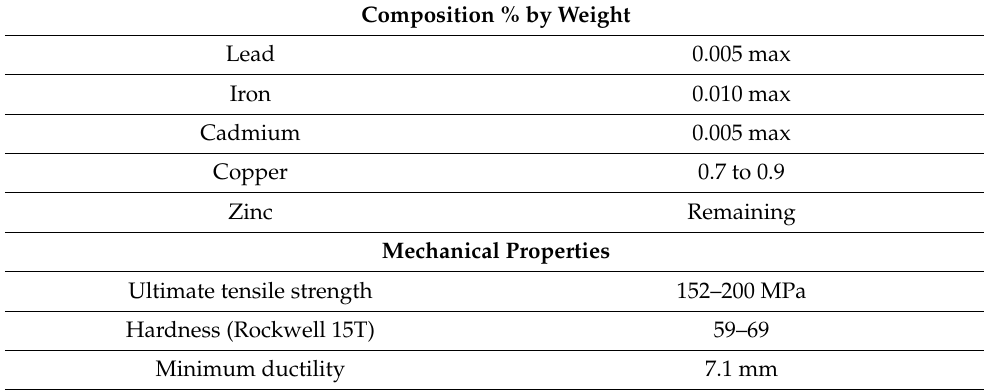
Figure 8. Specimen production with rebar and Zn mesh anode for CP performance evaluation. ( a ) Rebar; ( b ) Zn mesh anode; ( c ) Specimen preparation; ( d ) Manufactured specimen. Table 4. Composition and mechanical properties of Zn mesh anode. Table 4. Composition and mechanical properties of Zn mesh anode.